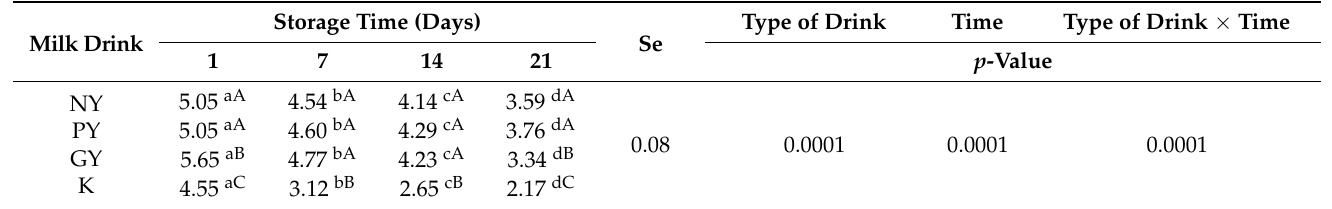
Table 2. Lactose content (%) in fermented milk drinks depends on the storage time (at 4 ◦ C) and the type of milk